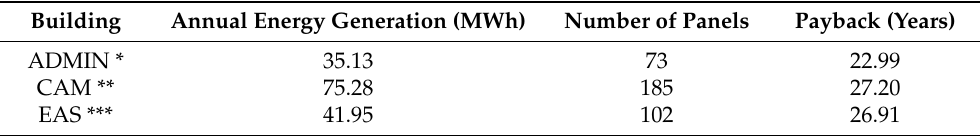
Table 3. Payback years based on the annual energy generation and the number of installed panels for ADMIN, CAM, and EAS